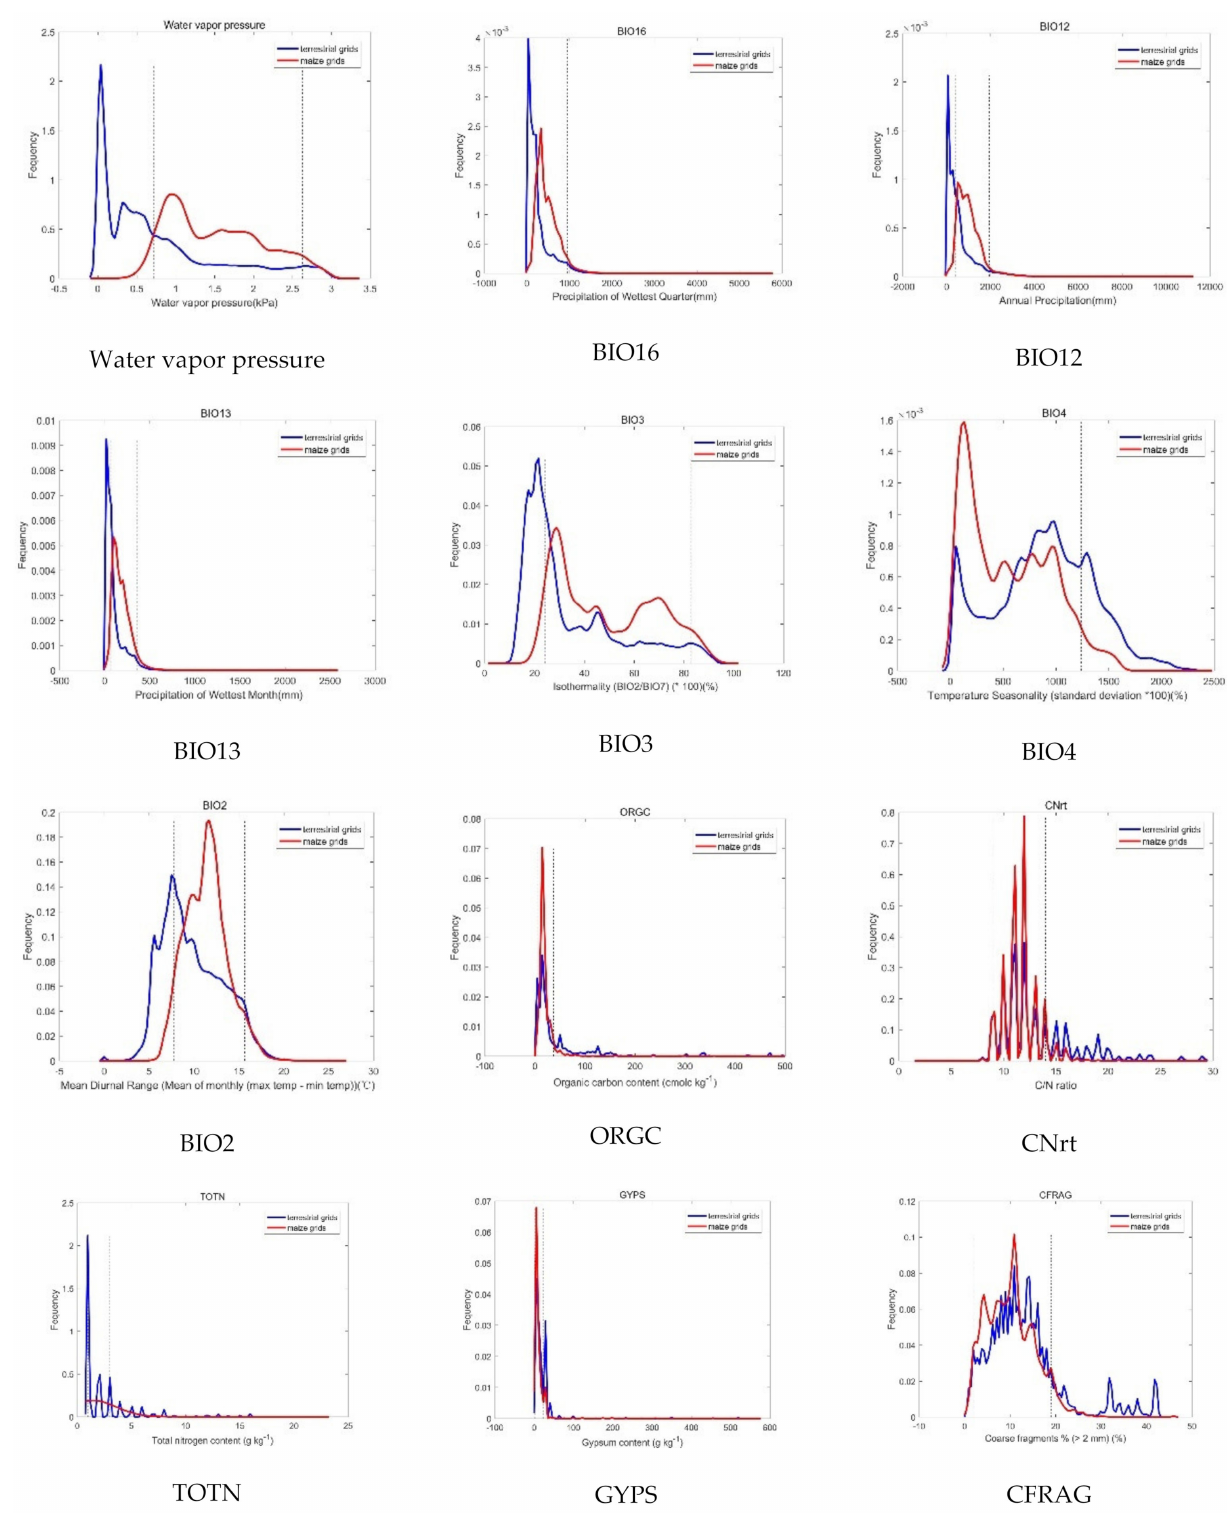
Figure A1. PDFs of initially selected environmental variables. Note: For each environmental variable, the blue line denotes its probability density function based on all of the global terrestrial grids and the red line is that based on the grids defined as the maize distribution area. The two vertical dotted lines are the 5th and 95th percentile lines,